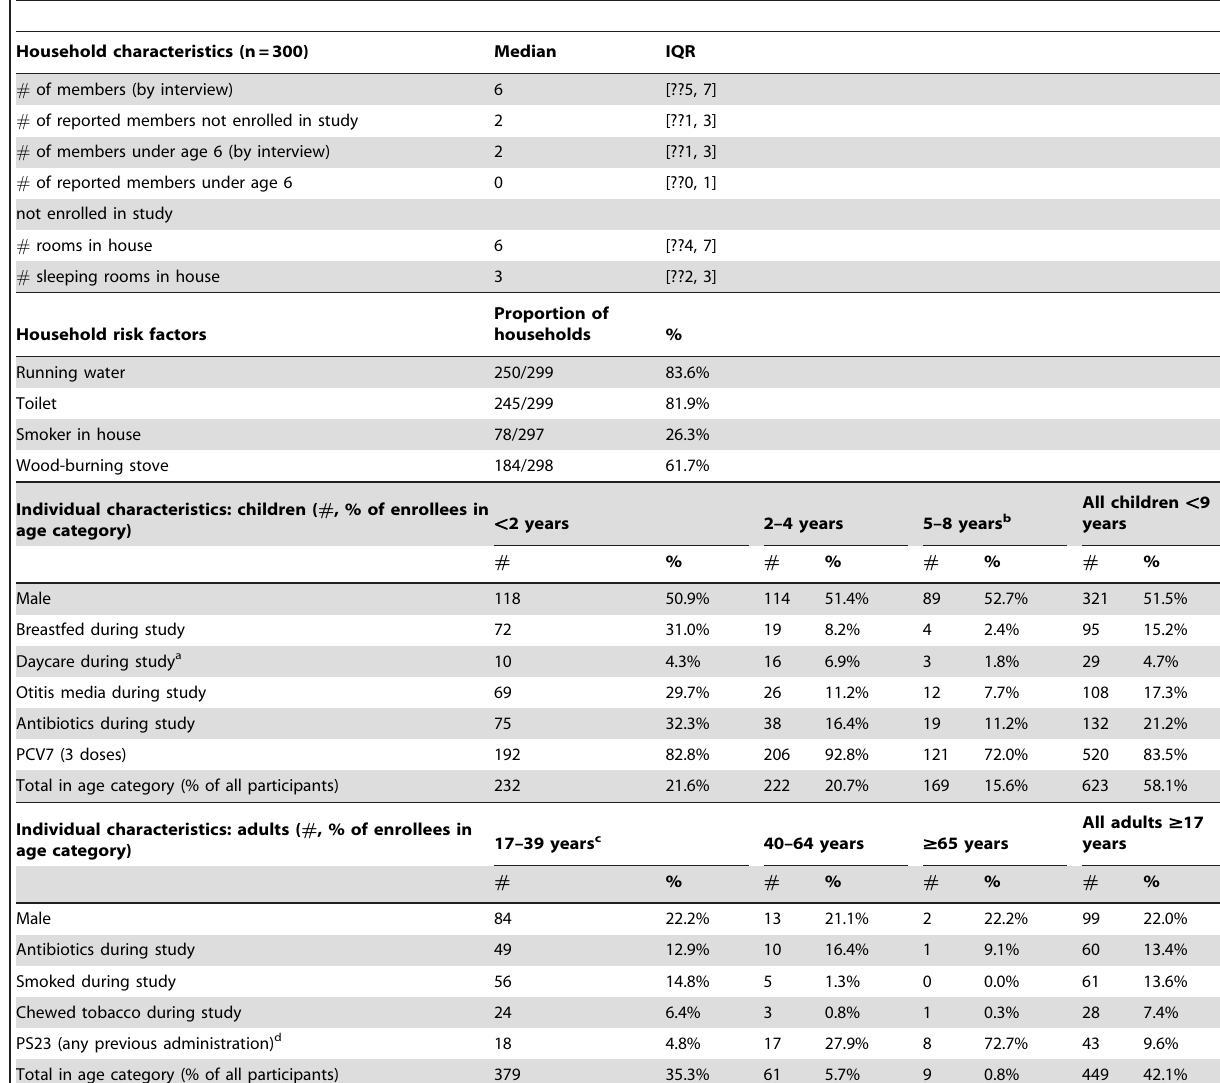
Table 1. Characteristics of individuals and households enrolled in the